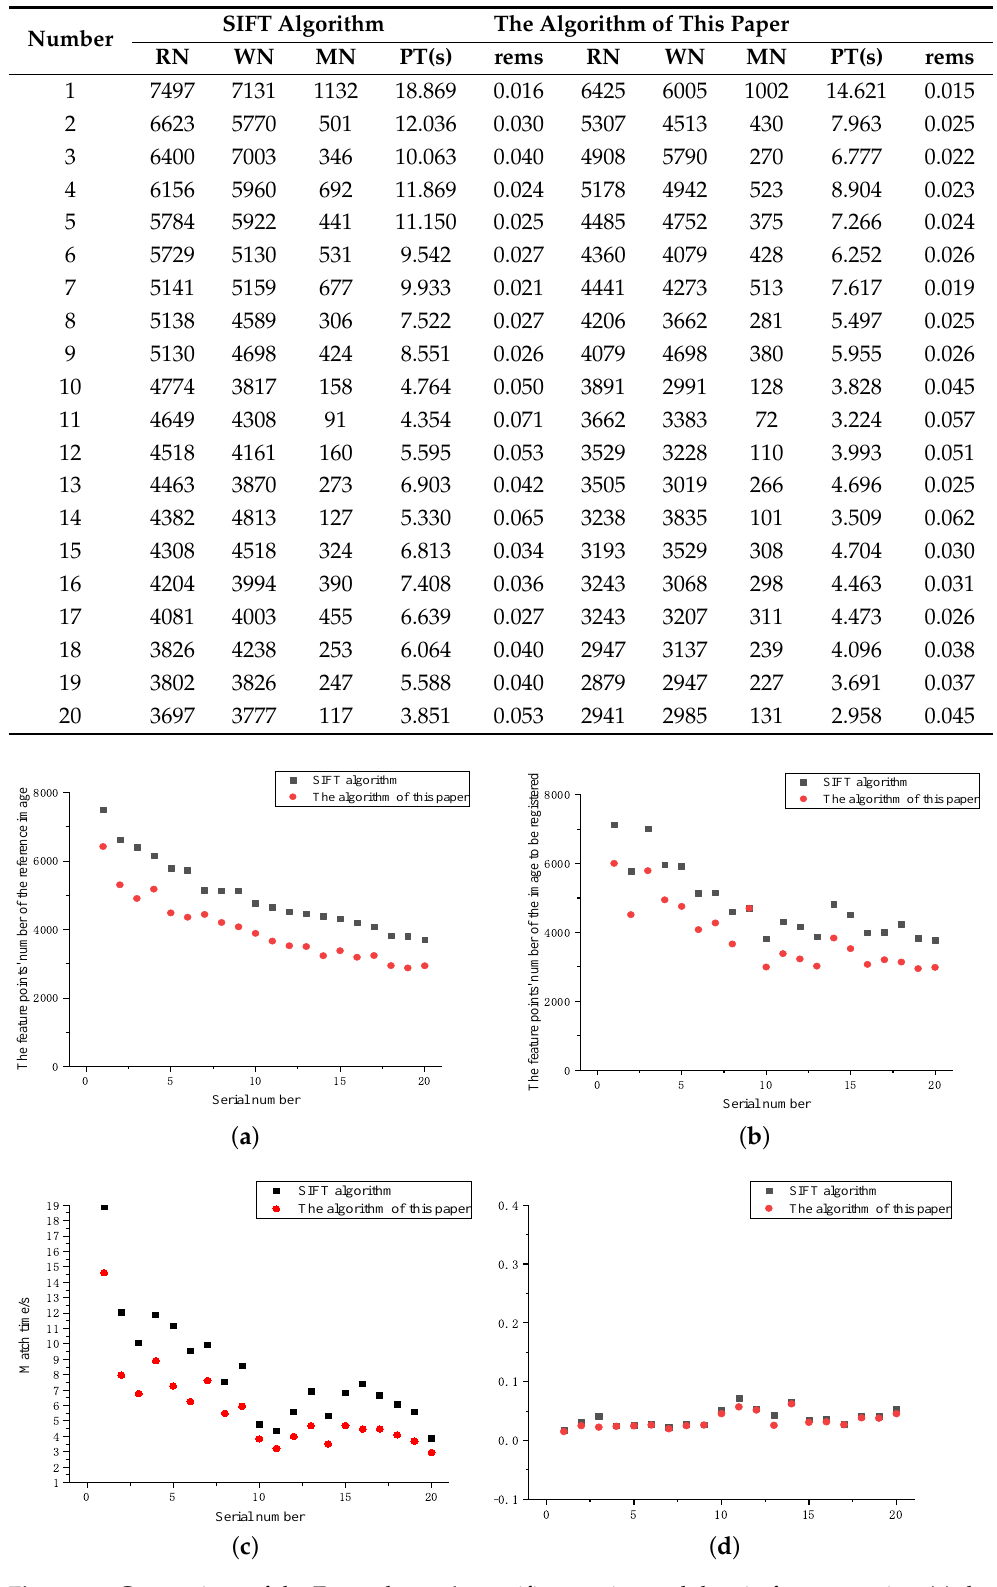
Table 2. Comparison of the results of Euroc.